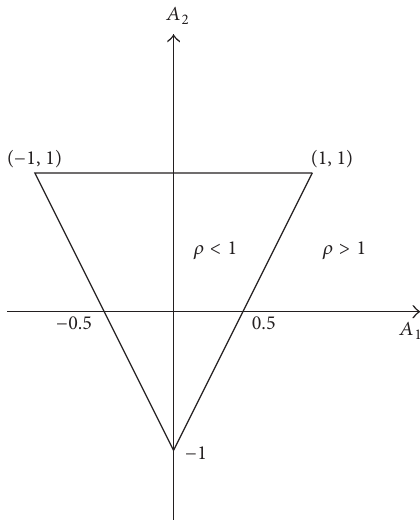
Figure 1: Stability domain of